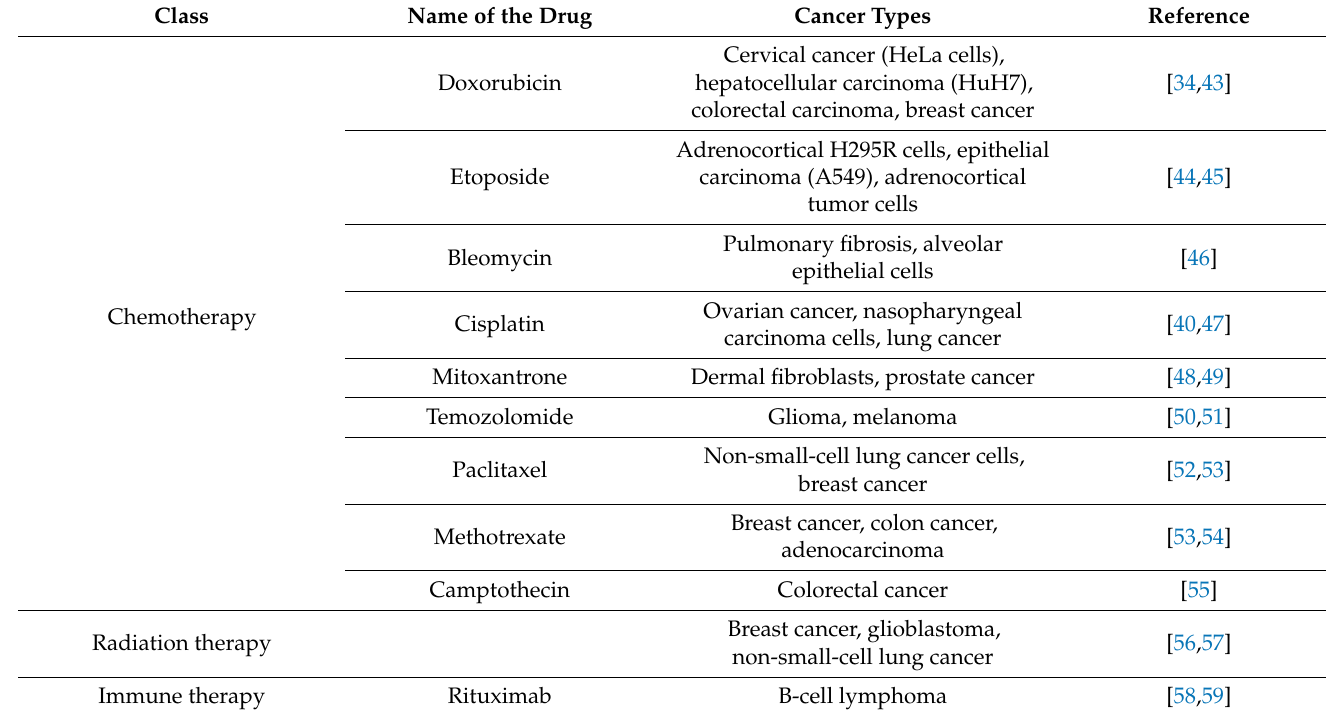
Table 1. List of anticancer therapies that induce